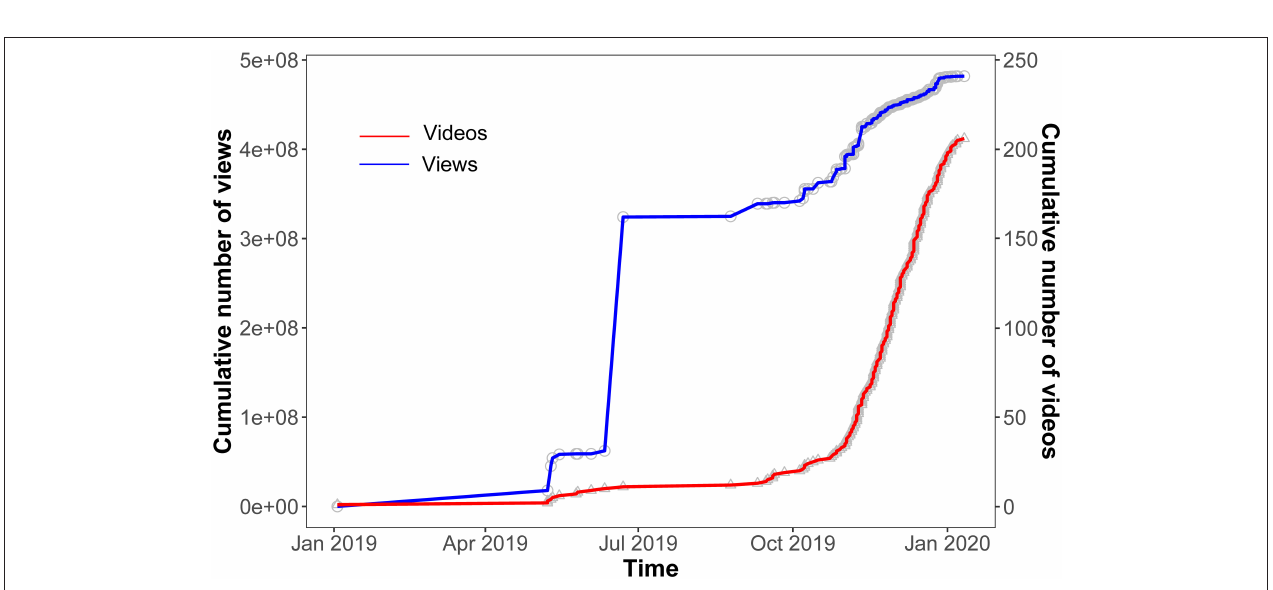
FIGURE 2 | Temporal pattern of the hunting and fishing experiment videos published on YouTube during the period Jan 2019–Jan 2020. Cumulative number of videos (red line, triangle) and views (blue line, circle). We note that the data presented here were only based on 1 year and does not take into account the potential effect of seasonal variability in the vulnerability of species to exploitation in their natural environment (wet vs. dry